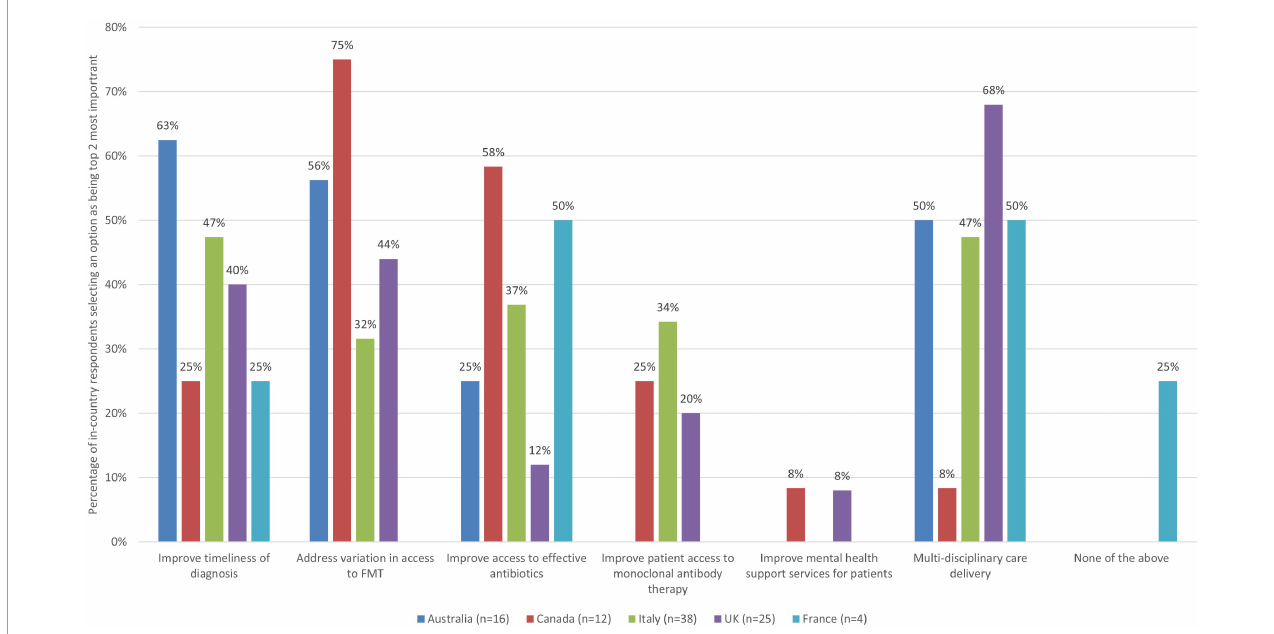
FIGURE2 The improvement actions related to access and organization of service delivery and quality of care for CDI that are the most important (bars represent the percentage of respondents that rated each improvement action as one of the most important by country).